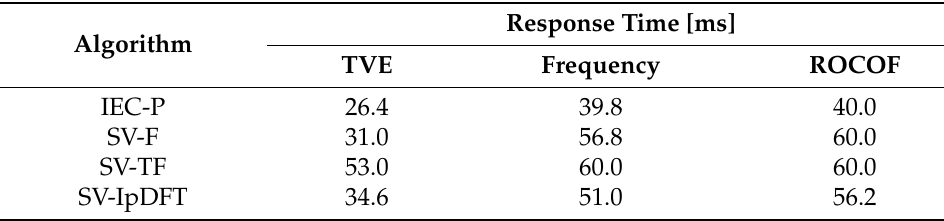
Table 2. Response times for − 10 ◦ phase step